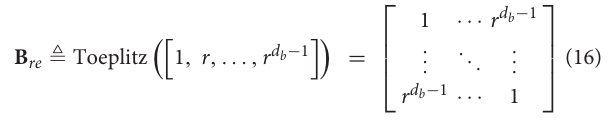
approximate B , it can be constrained to the following form of the Toeplitz matrix.